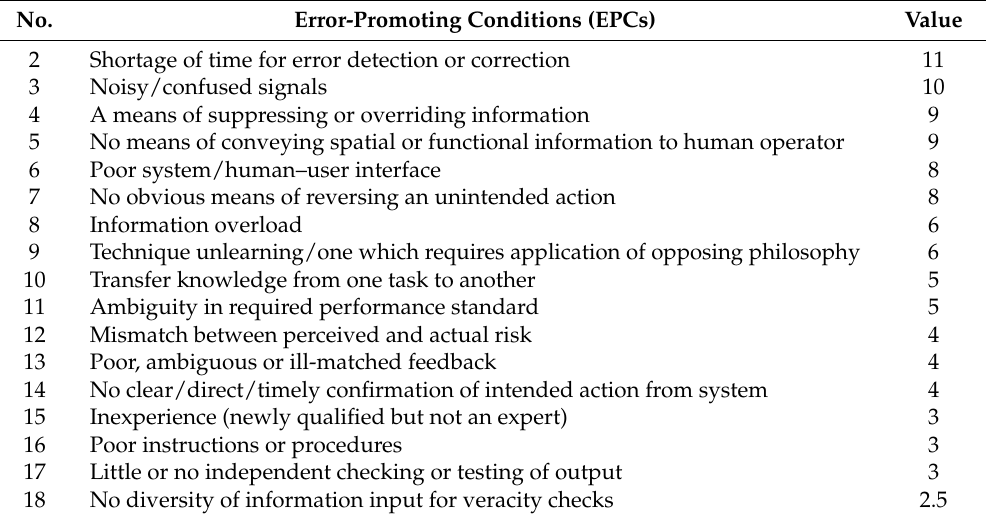
Table A2. The most used error-promoting conditions (EPCs) according to Williams